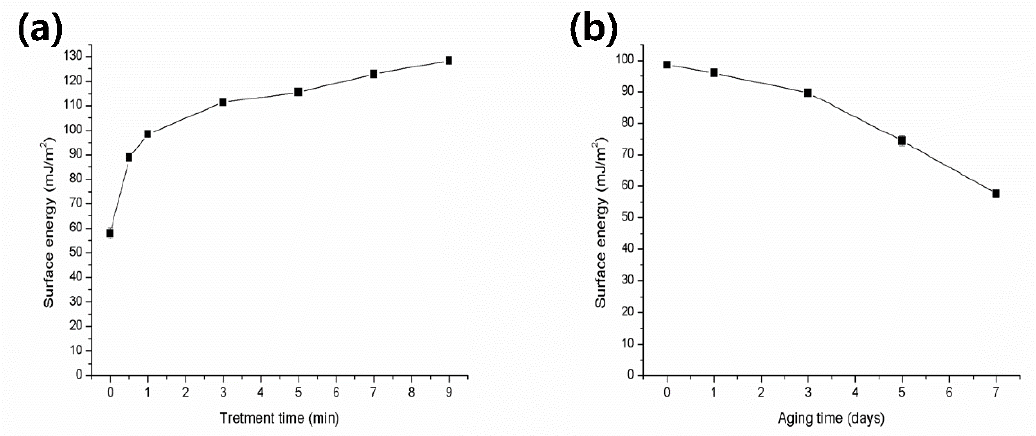
Figure 5. The calculated surface energy on the surface of epoxy resin as; ( a ) increasing treatment time of non-thermal atmospheric pressure nitrogen plasma; ( b ) time following the treatment to non-thermal atmospheric pressure nitrogen plasma. There was a statistically significant difference ( p < 0.05) between all test groups.